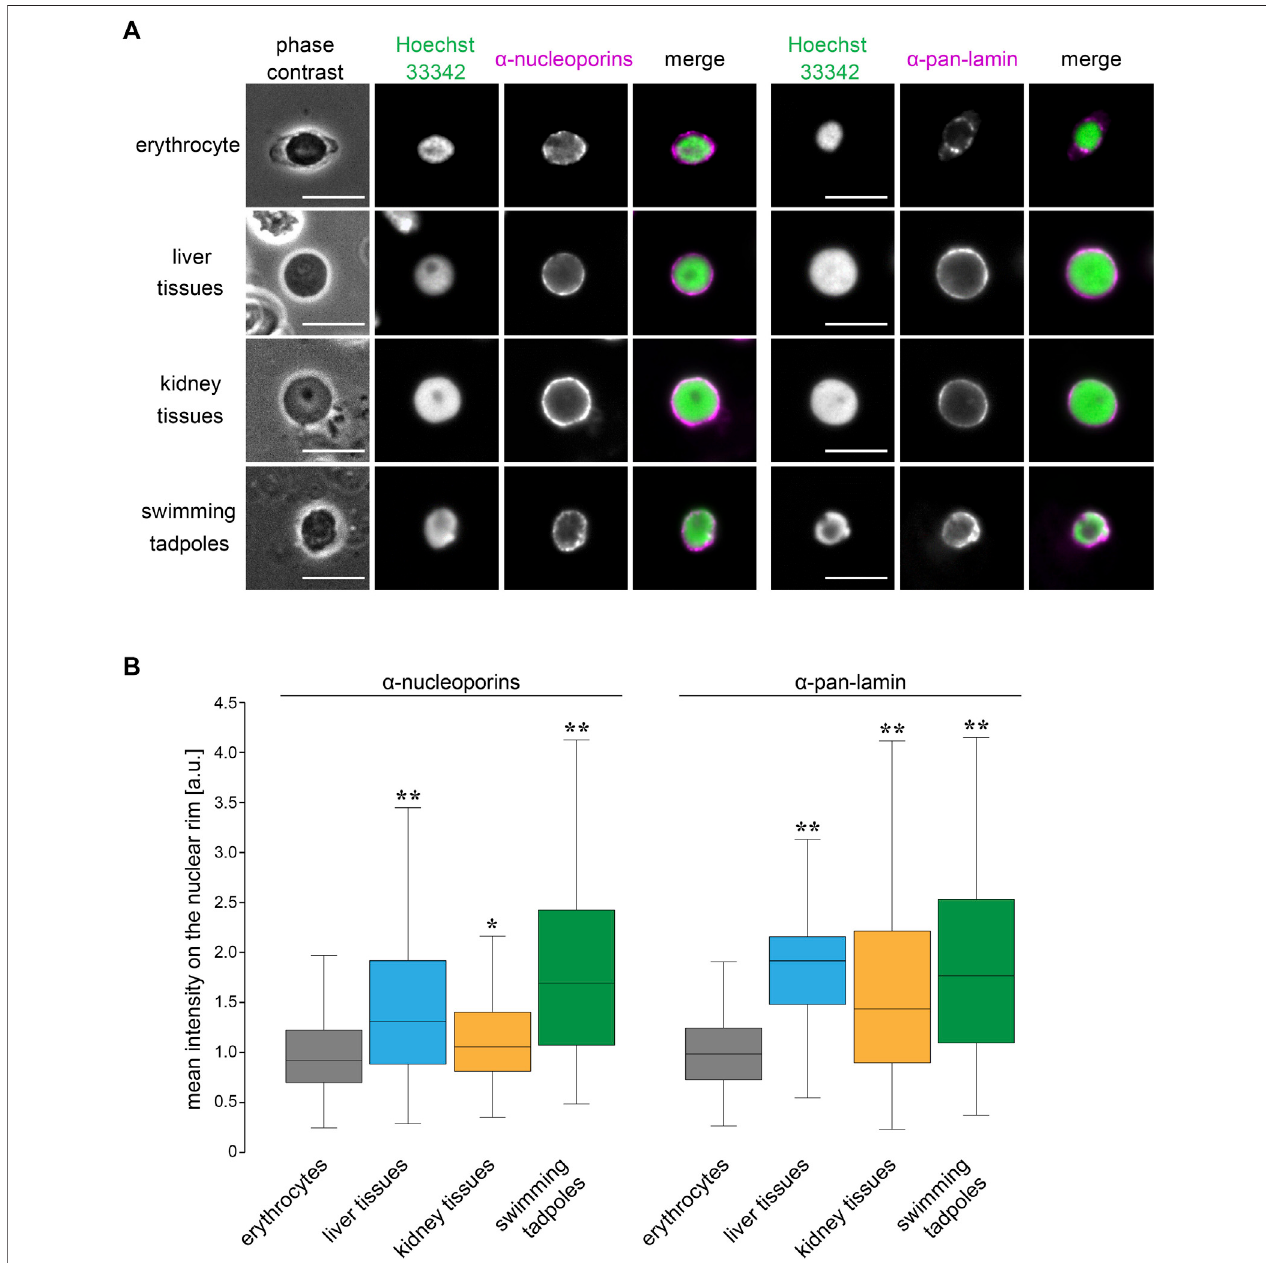
FIGURE 6 | Structural properties of nuclear membrane in X. laevis erythrocytes.(A) Immunostaining using anti-nucleoporins (left; magenta) or anti-pan-lamin (right; magenta)antibodies,withDNAstainingusingHoechst33342(green),inerythrocytes,isolatednucleifromliver,kidneycells,andswimmingtadpolesof X.laevis .Merged images of each immunostaining signal with DNA signals have been shown. Scale bar = 10 μ m. (B) Mean intensity of the immunostaining signals for anti-nucleoporins or anti-pan-lamin antibodies was represented in a box plot. The measured intensities from erythrocytes and other cells were normalized to the mean intensity of erythrocytes. Samples number (n) from erythrocytes: 71 (nucleoporins), 105 (lamins); liver cells: 86 (nucleoporins), 122 (lamins); kidney cells: 86 (nucleoporins), 122 (lamins); swimming tadpoles: 86 (nucleoporins), 122 (lamins). The statistical difference between data from erythrocytes and other tissues and embryos was analyzed using the Wilcoxon test (** p < 0.005 and * p < 0.05).